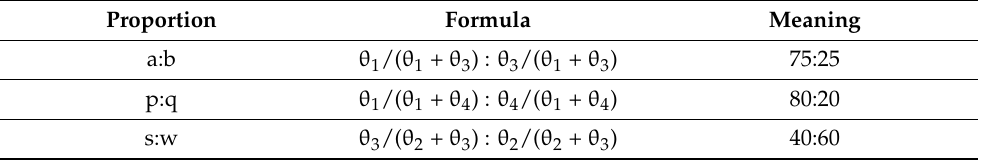
Figure 2. Zoning scheme. Screen zoning layout based on data from Tables 6 and 7 is shown in Figure 3. Table 6. Screen zoning.